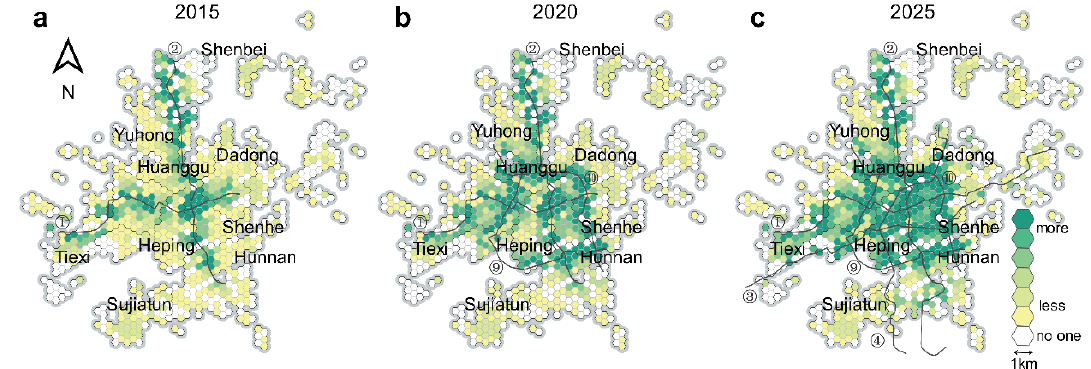
Figure 8. Spatial walking accessibility to healthcare services at different stages of subway system development: ( a ) accessibility in 2015; ( b ) accessibility in 2020; ( c ) accessibility in 2025.